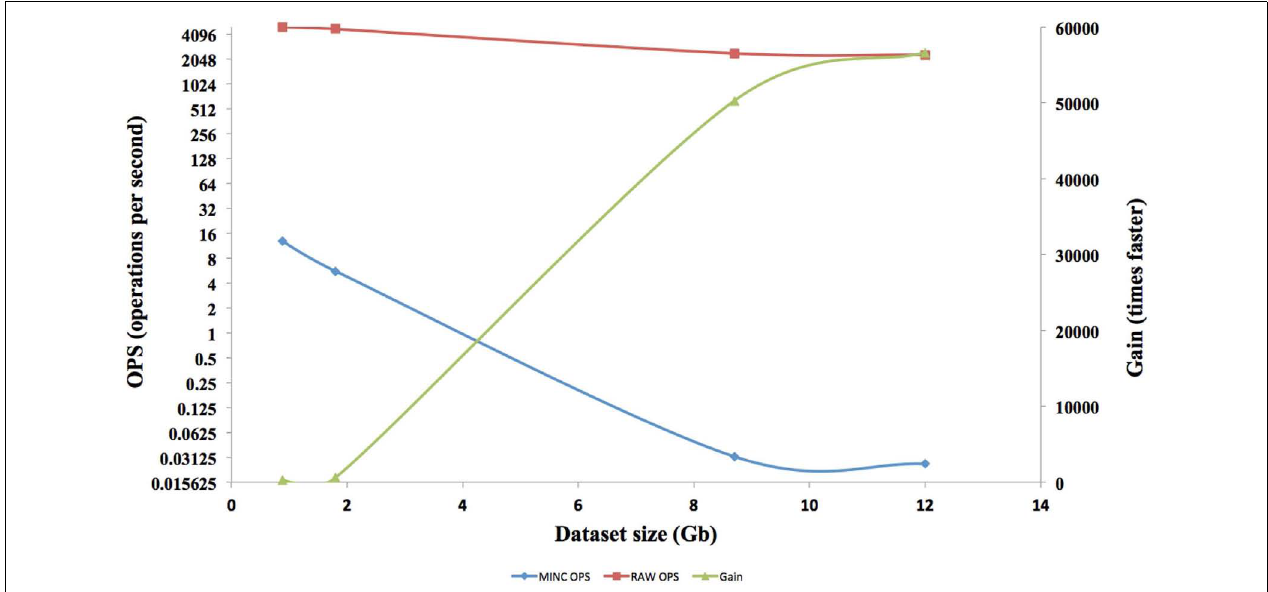
FIGURE 7 | Operation per seconds and Gain speed comparing MINC and Raw files